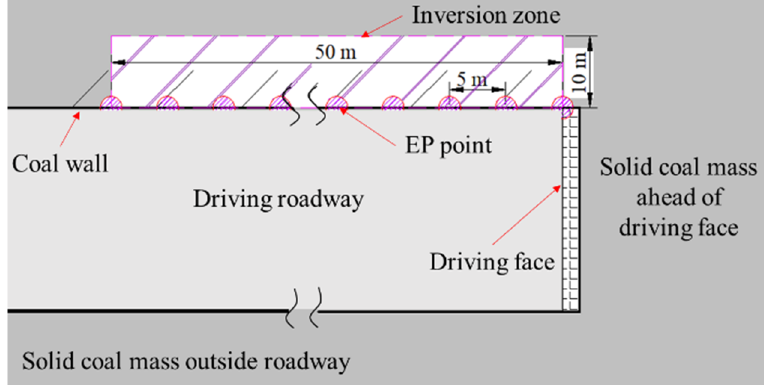
Figure 7. Schematic diagram of unilateral inversion EP measuring points arrangement of coal wall in the driving roadway.